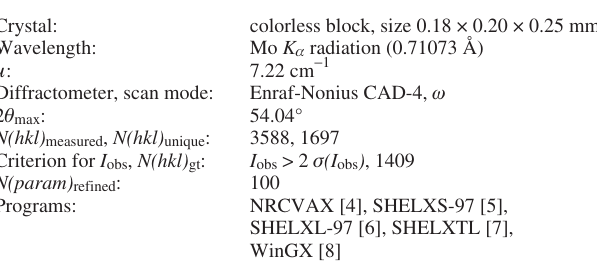
Table 1. Data collection and handling.